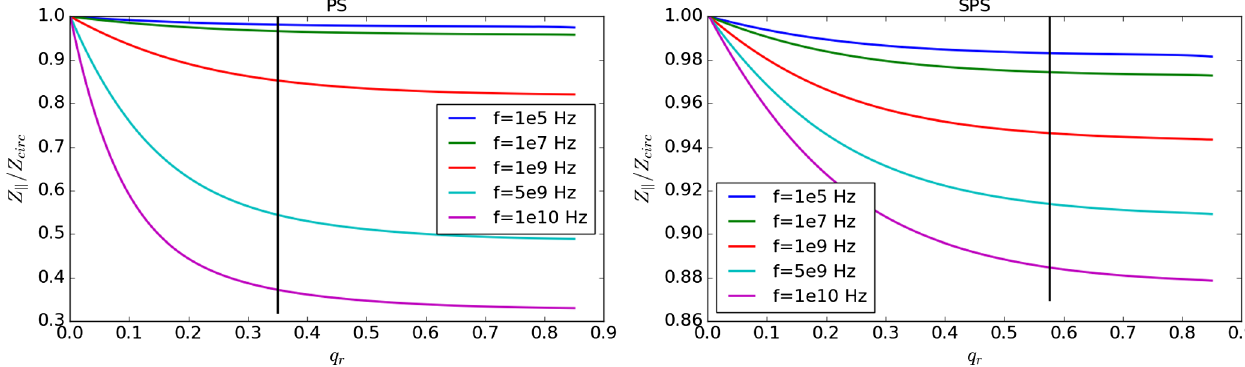
FIG. 7. Longitudinal form factor as a function of q r ¼ ð a − b Þ = ð a þ b Þ for the PS (left) and the SPS (right) injection energies at different frequencies. The vertical black lines correspond to the machines beam pipe geometries.